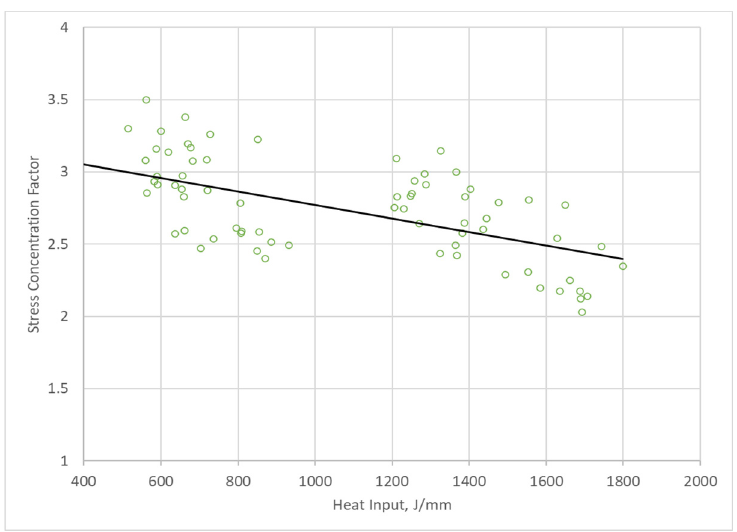
Figure 4. Relationship between the amount of heat input to the welded joint and the stress concen- tration.